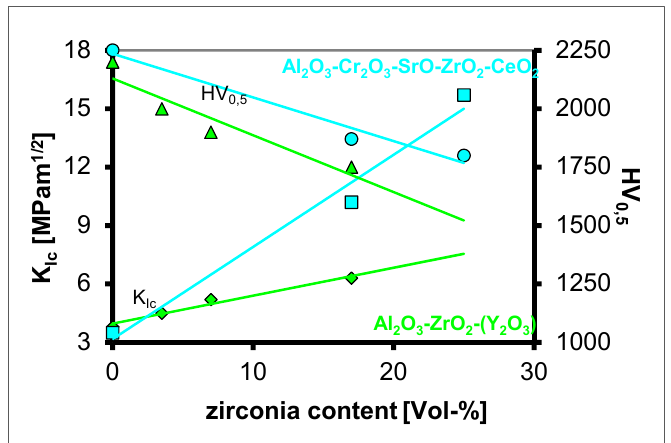
Figure 32. hardness and fracture toughness of the system Al 2 O 3 -Cr 2 O 3 -ZrO 2 -CeO 2 -SrO. Figure 32. Hardness and fracture toughness of the system Al